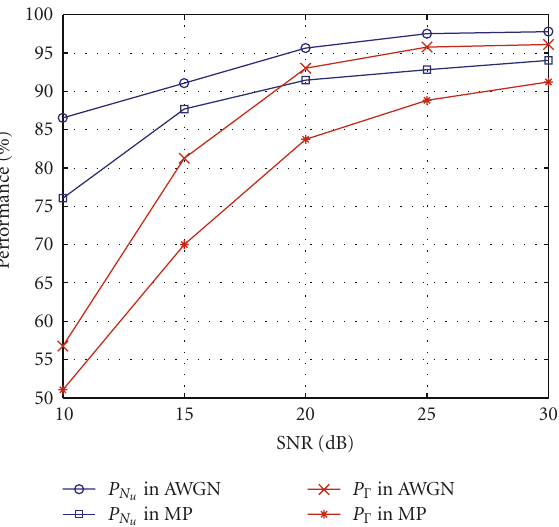
Figure 7: Performances in finding the number of users and separat- ing the user subcarriers in AWGN and MP channels assuming the same SNR for all users.